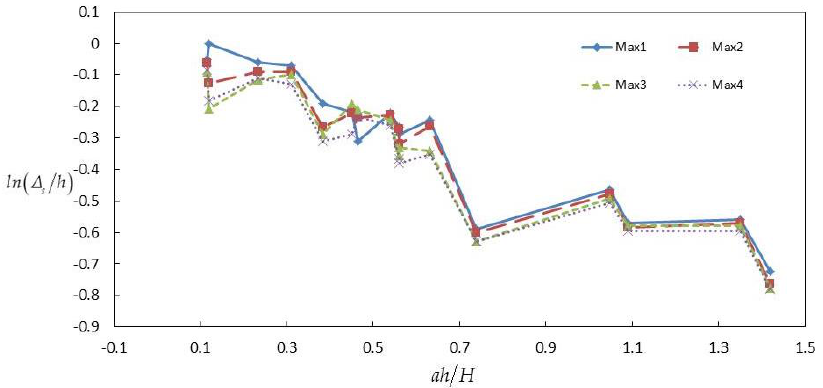
Figure 9. Height of the theoretical zero point Δ s varies with the comprehensive parameter ah/H . (calculated from original velocity data with different velocity integration in experiments of Dunn et al. [1]).